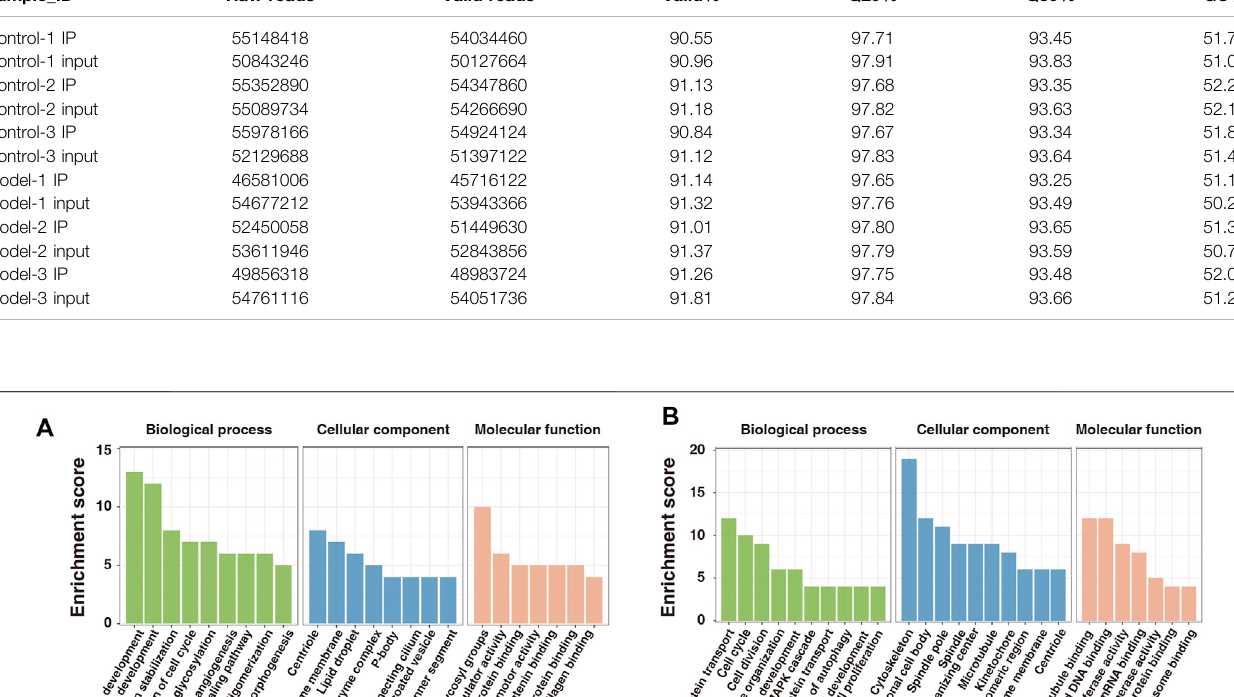
Frontiers in Genetics |